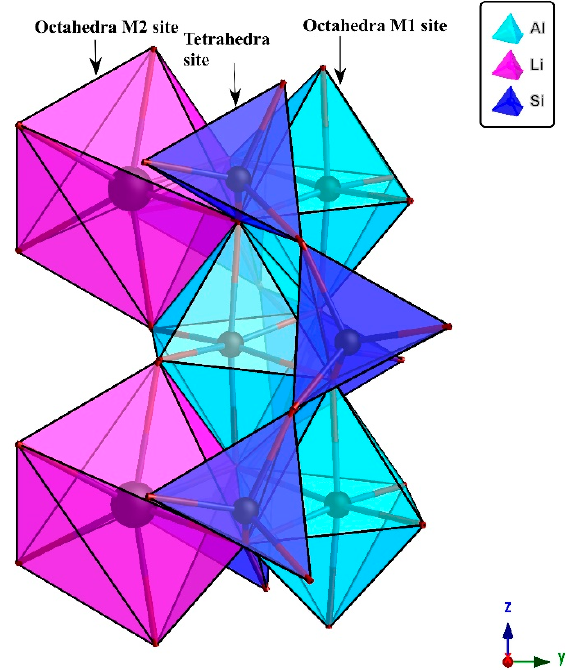
Figure 1. This polyhedral model of a spodumene crystal, using the crystal refinement data of [5] was drawn through CrystalMaker X software, with the following unit cell parameters ( a : 9.46, b : 8.412 and c : 5.224 Å, α : 90, β : 110 and γ : 90 degree). There is a total of 40 atoms in one complete unit cell. The basic building blocks: AlO 6 ( M 1) and LiO 6 ( M 2) are at octahedral, while SiO 4 are at tetrahedral positions as labeled in the picture. The crystallographic orientation is shown at the bottom right corner, projected down the x-axis.